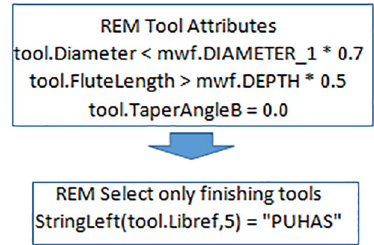
Fig. 7. Decision making rules for tool selection.